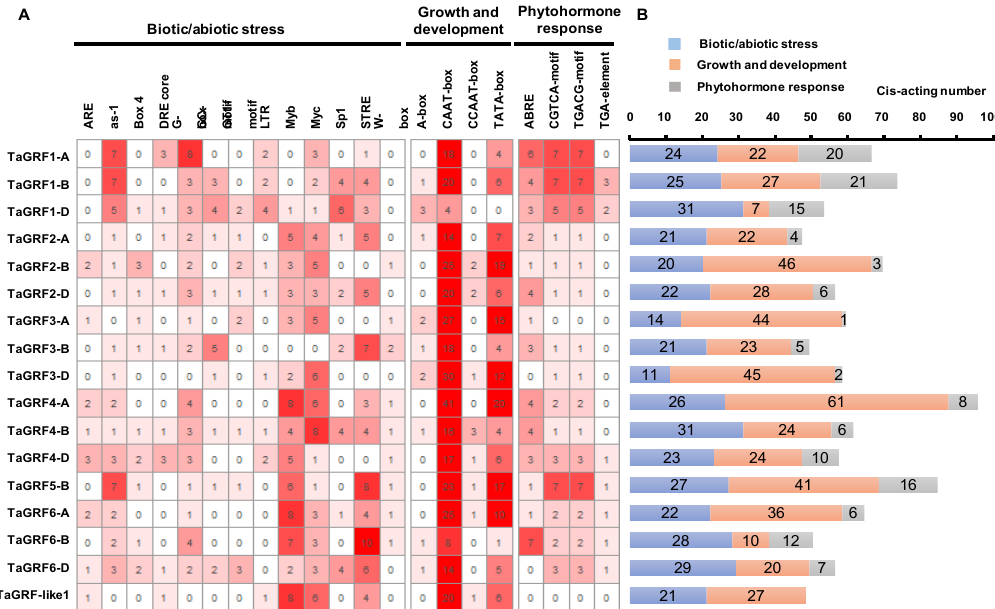
Figure 3. Analysis of cis -acting elements in the promoter of TaGRFs . ( A ) Different numbers and shades of color in the grid indicated the number of different promoter elements. ( B ) The histogram showed the sum of the cis-acting elements in different classes of each gene.